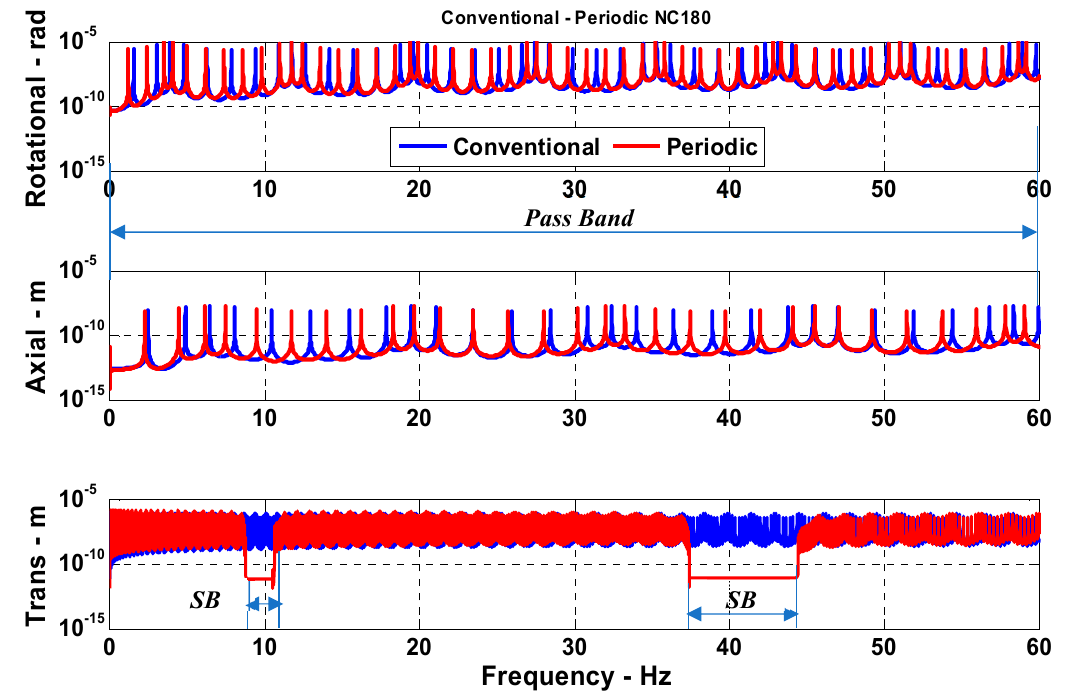
Figure 9. Comparisons between the frequency response characteristics of a conventional drill-string and a drill-string with 180 passive periodic inserts ( SB: Stop band).